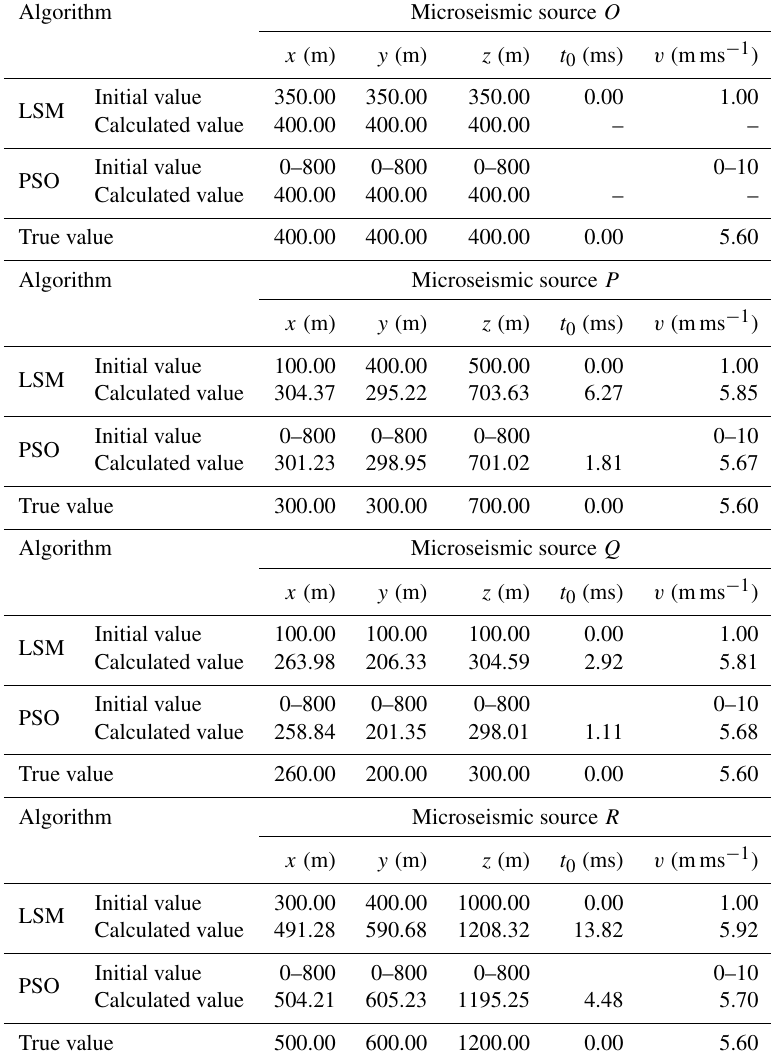
Table 3. Comparison of the LSM and PSO